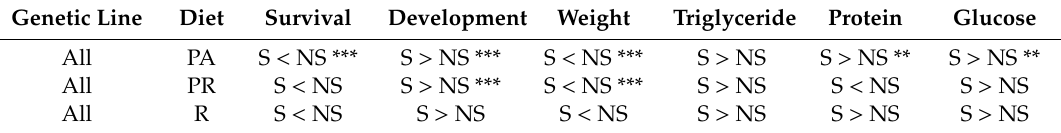
Table 2. The influence of parental microbiota on larvae phenotypes. Comparison of larvae life history traits and metabolic phenotypes between larvae, from all 10 genetic lines, raised on regular lab diet (R), peach diet (PR), and autoclaved peach diet (PA). NS stands for non-sterilized larvae, S stands for sterilized larvae. Asterisks indicate the uncorrected significance of comparisons p < 0.001 *** and p < 0.01